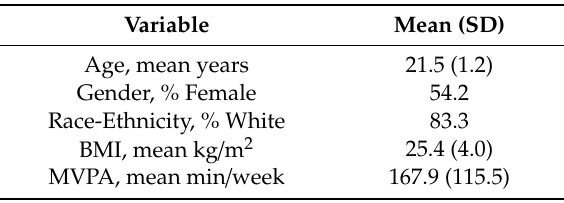
Table 1. Characteristics of the